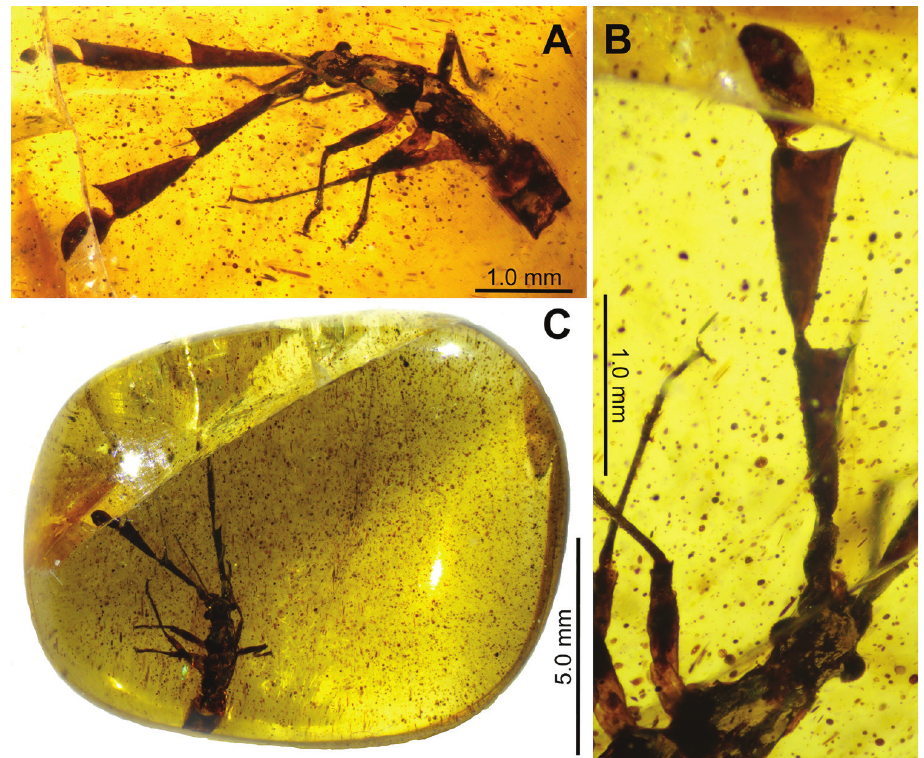
Figure 3. Ferriantenna excalibur gen. et sp. nov. holotype A dorsolateral habitus B left antennae lateral and head dorsal C amber specimen #BHM10200800678 showing the